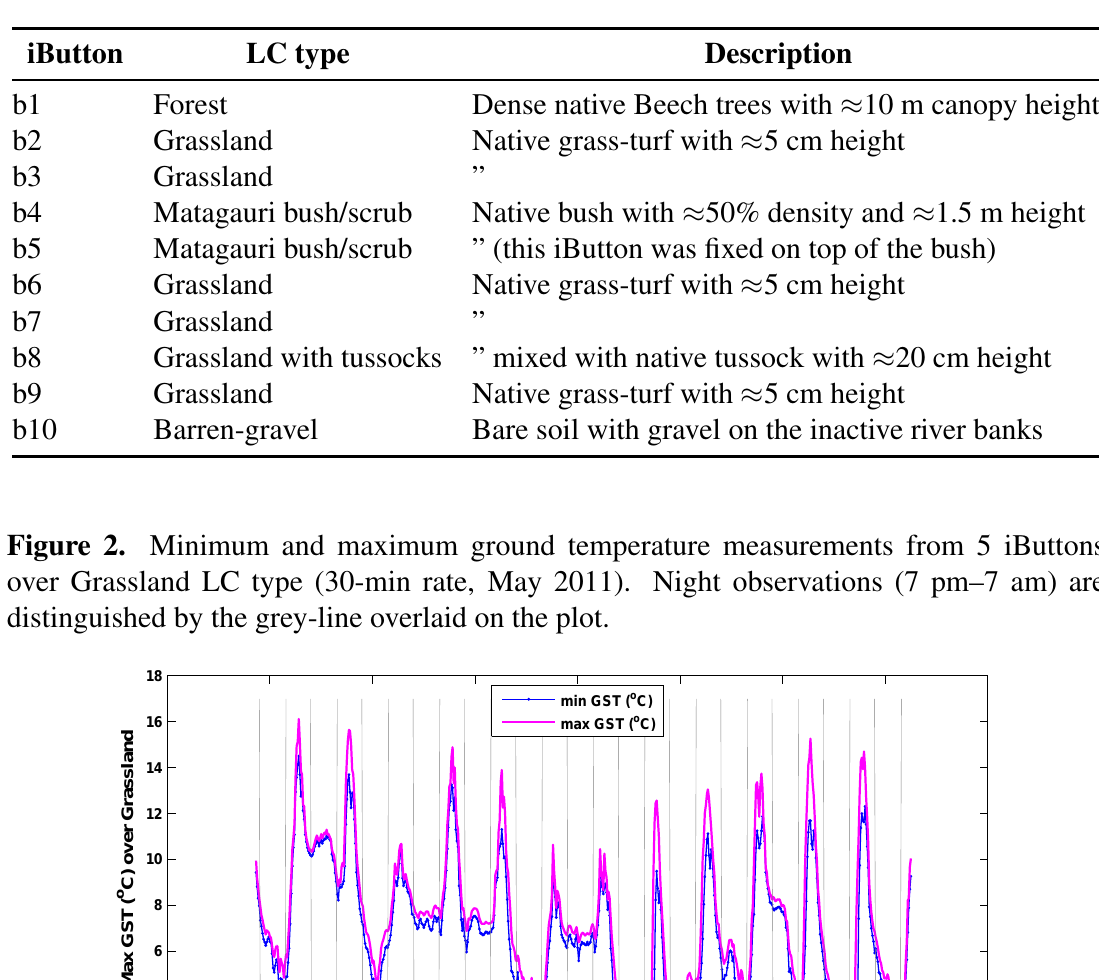
Table 1. Specifications of iButton measurement sites. All iButtons were buried at a depth of